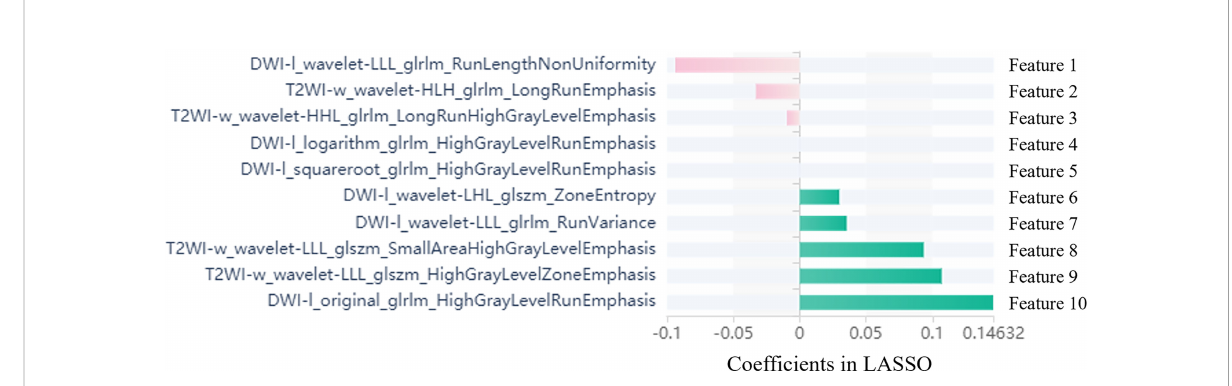
FIGURE 2 Selected radiomics features with associated coef fi cients in the LASSO model. DWI-l: lesion segmentation of DWI; T2WI-w: whole prostate segmentation of T2WI. GLSZM: Gray level size zone matrix; GLDM: Gray Level dependence; GLRLM: Gray level run length matrix; NGTDM: Neighborhood gray tone difference matrix; Wavelet: The wavelet transform decomposes the tumor area image into low-frequency components (L) or high-frequency components (H) in the x, y, and z axes.